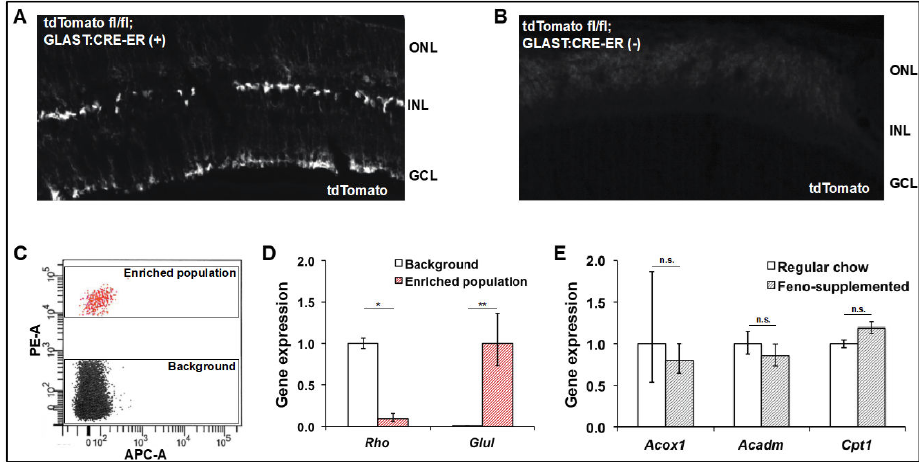
Figure 5. PPAR α target genes are not upregulated in Müller glia isolated from mice treated with a fenofibrate-supplemented diet. ( A ) When GLAST-CreER; R26CL -tdTomato transgenic mice are induced with tamoxifen, robust expression of tdTomato is noted in the Müller glia. ( B ) while no tdTomato expression is seen in the retinas of mice lacking the GLAST-CRE-ER transgene. ( C ) GLAST- CreER and R26CL- tdTomato fl/fl transgenic mice were started on a fenofibrate-supplemented diet or kept on regular chow at one month of age, and were then induced with tamoxifen. At six months of age, the retinas were harvested, dissociated, and tdTomato+ cells were isolated using fluorescence activated cell sorting (FACS). ( D ) The rod marker rhodopsin was depleted in the sorted population, while glutamine synthetase, a Müller glia marker, was significantly enriched ( n = 4, Student’s t -test). ( E ) There was no difference in the expression of the PPAR α targets Acox1 , Acadm , and Cpt1a in enriched Müller glia populations isolated from mice treated with fenofibrate-supplemented diet or regular chow ( n = 3, Student’s t -test). ONL (outer nuclear layer), INL (inner nuclear layer), GCL (ganglion cell layer). * = p < 0.05, ** = p <